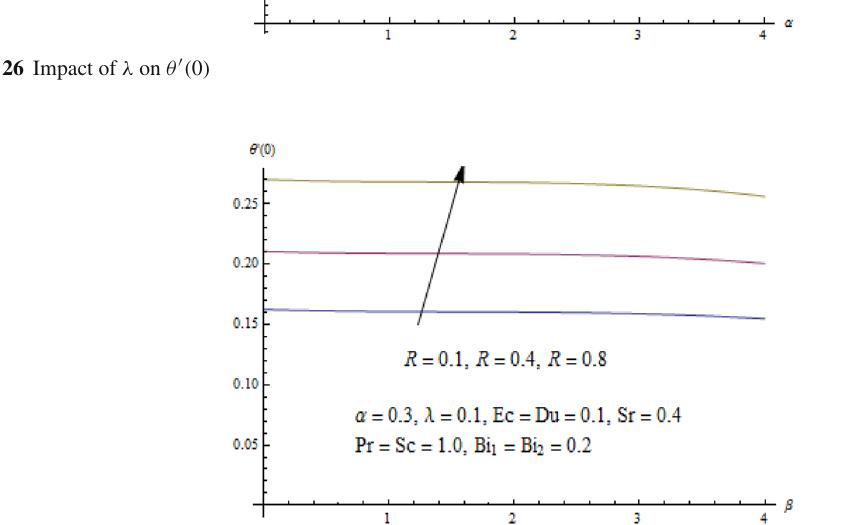
Fig. 27 Impact of R on θ (cid:5) ( 0